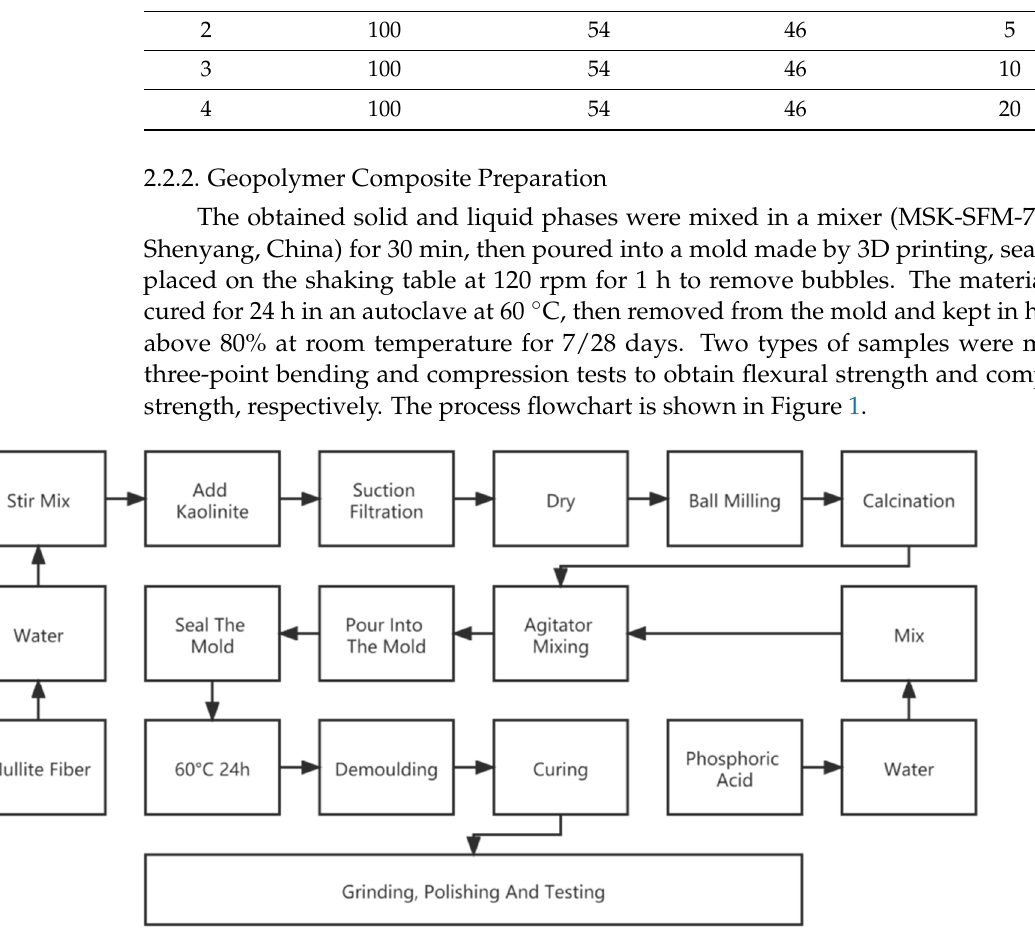
Figure 1. Preparation process of mullite fiber geopolymer composite.